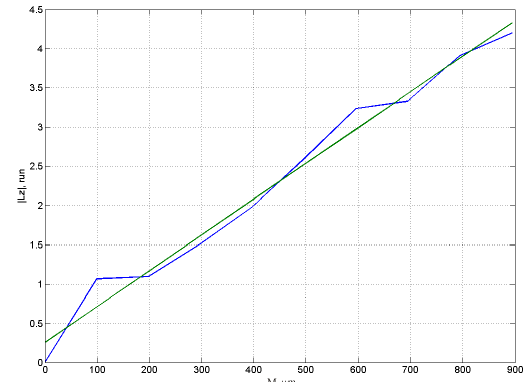
Fig. 5. An experimental dependence of the absolute value of the radius increment of the round mark image on the vibrational displacement of the investigated material